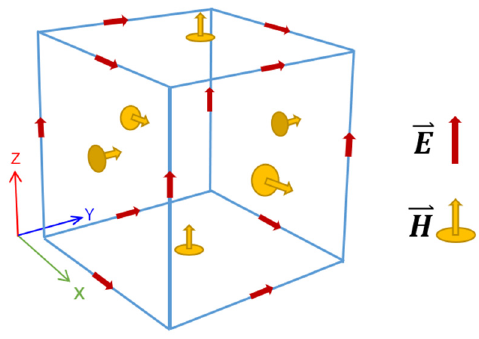
Figure 1. Distribution of electromagnetic fields in Yee’s grid [24].